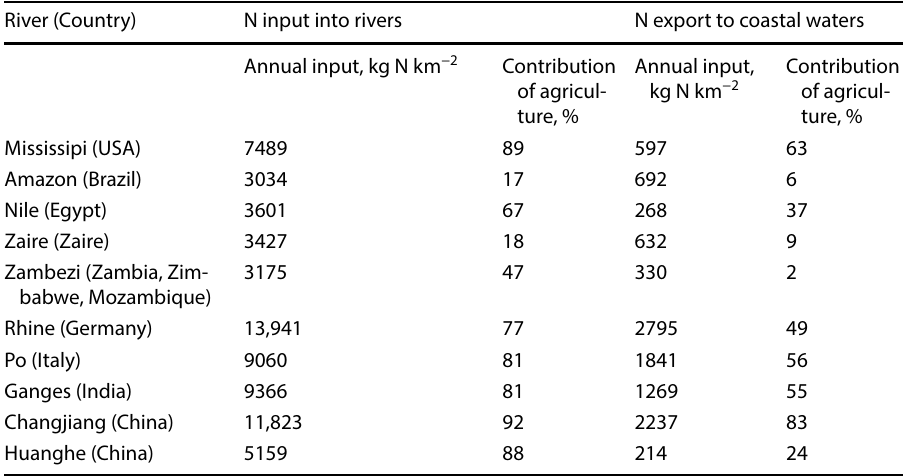
Adapted from van Drecht et